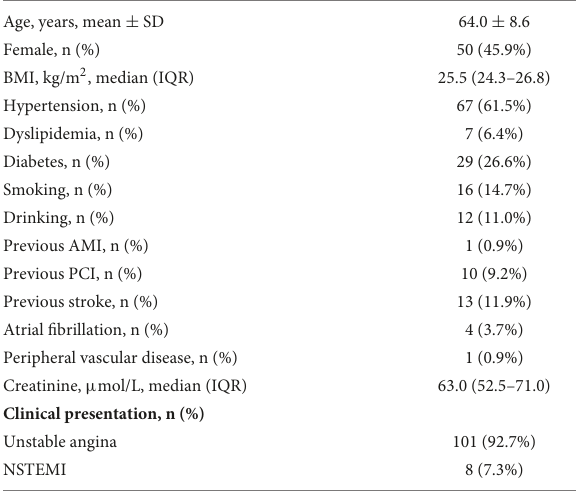
TABLE 1 Baseline clinical